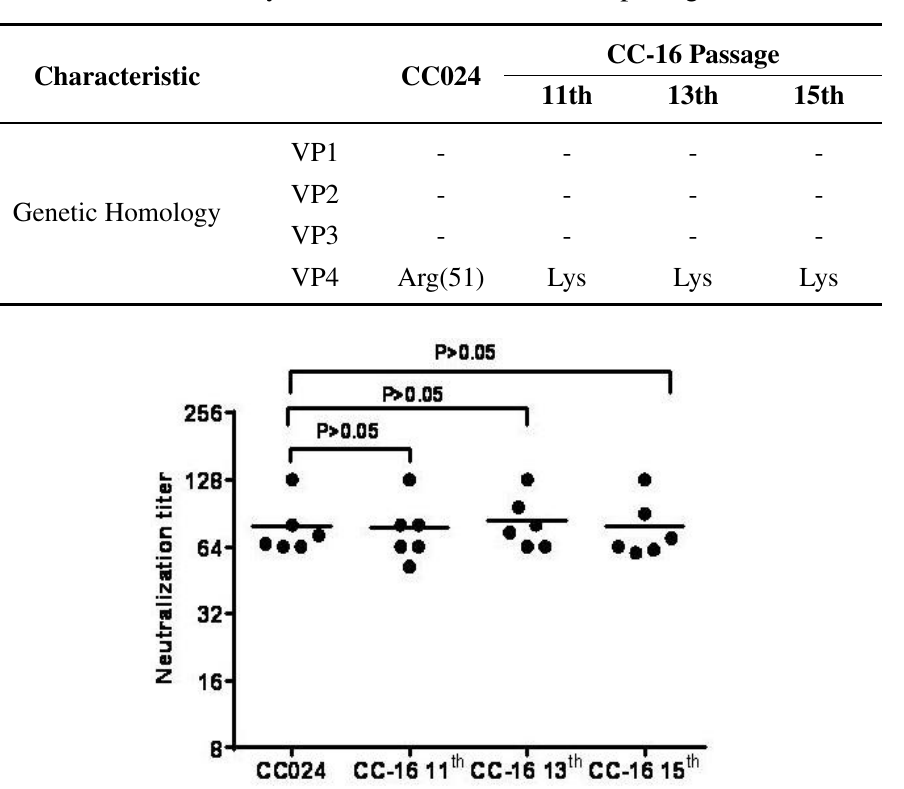
Figure 5. Neutralizing antibody titers of the 11th, 13th and 15th passages of CA16 CC-16. ICR mice ( n = 6) were immunized with the same procedure and dose. Neutralization titers of the sera were determined as described in Materials and Methods and plotted (Y-axis) on a logarithmic